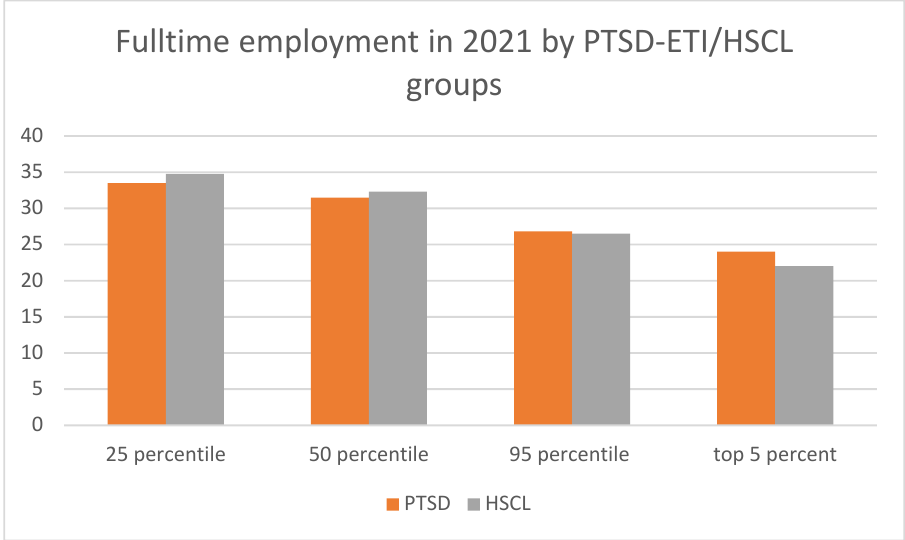
Figure 1. Distribution of PTSD-ETI and HSCL-10 scores in 2016. Source: IAB-WELLCOME study wave 1.